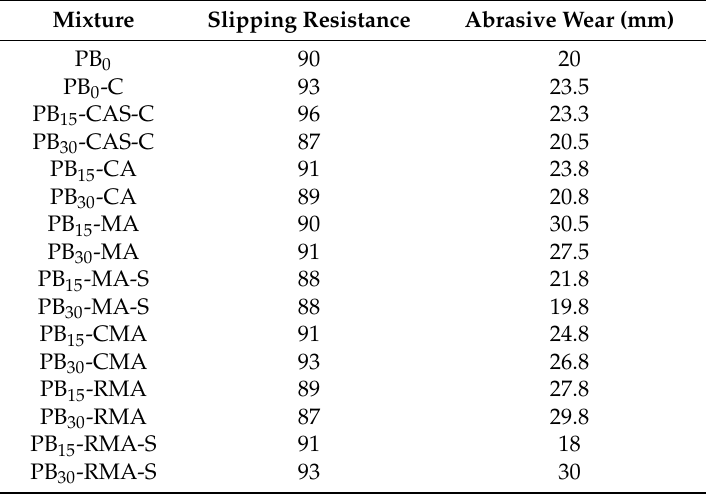
Table 12. Slipping and abrasive resistance after 90